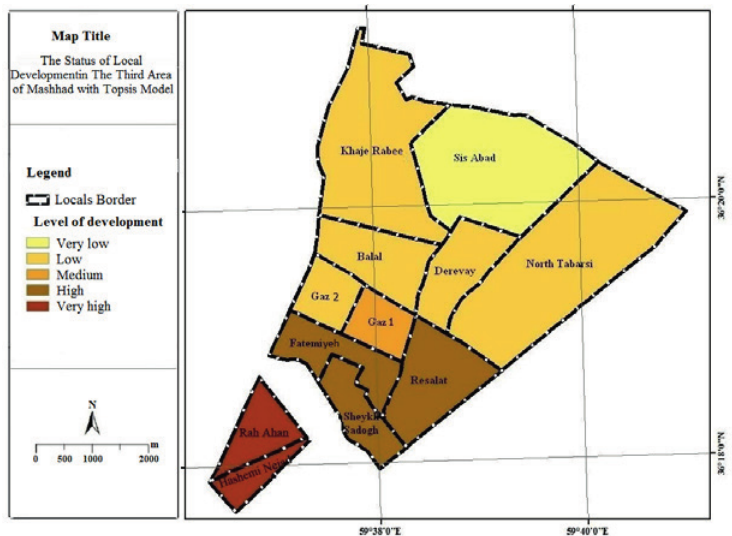
Fig. 4. Total rating of neighborhood development in district three of Mashhad with TOPSIS